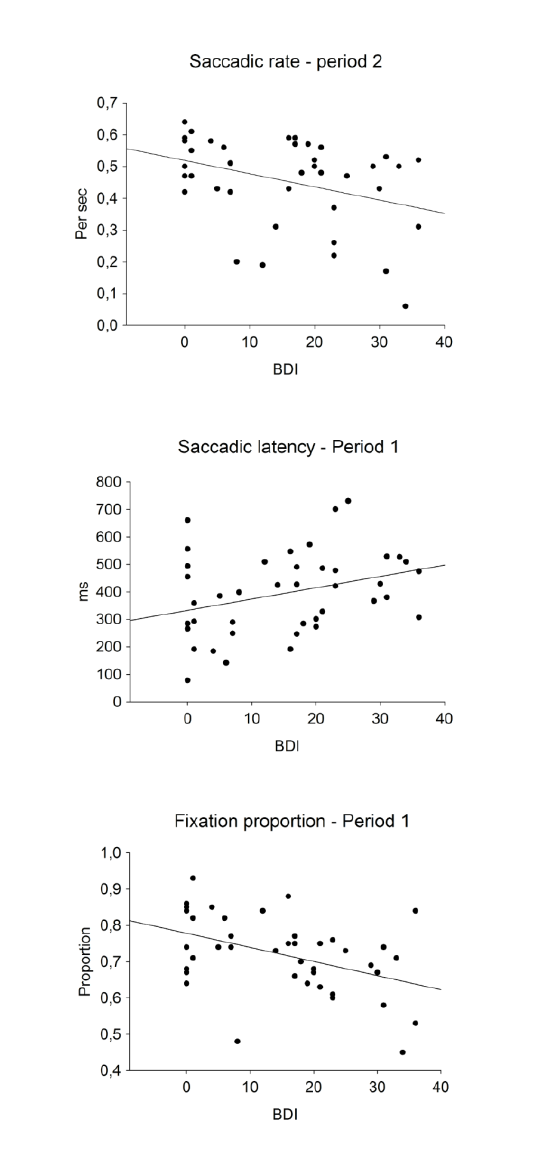
Figure 4. Scatter plots of selected significant correlations between BDI-II scores and means of eye-movement measures in different time periods. The bottom panel shows fixation proportions on the first speaker when he